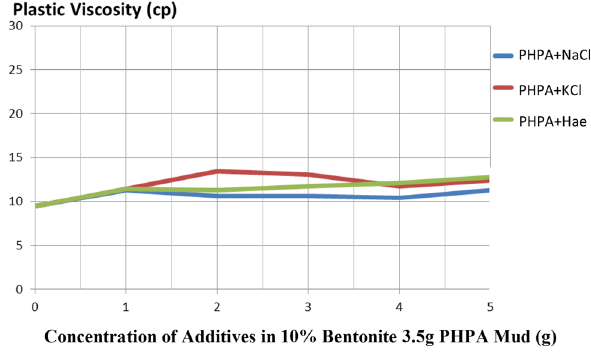
Fig. 15 Effect of NaCl, KCl and haematite on apparent viscosity of PHPA–bentonite mud